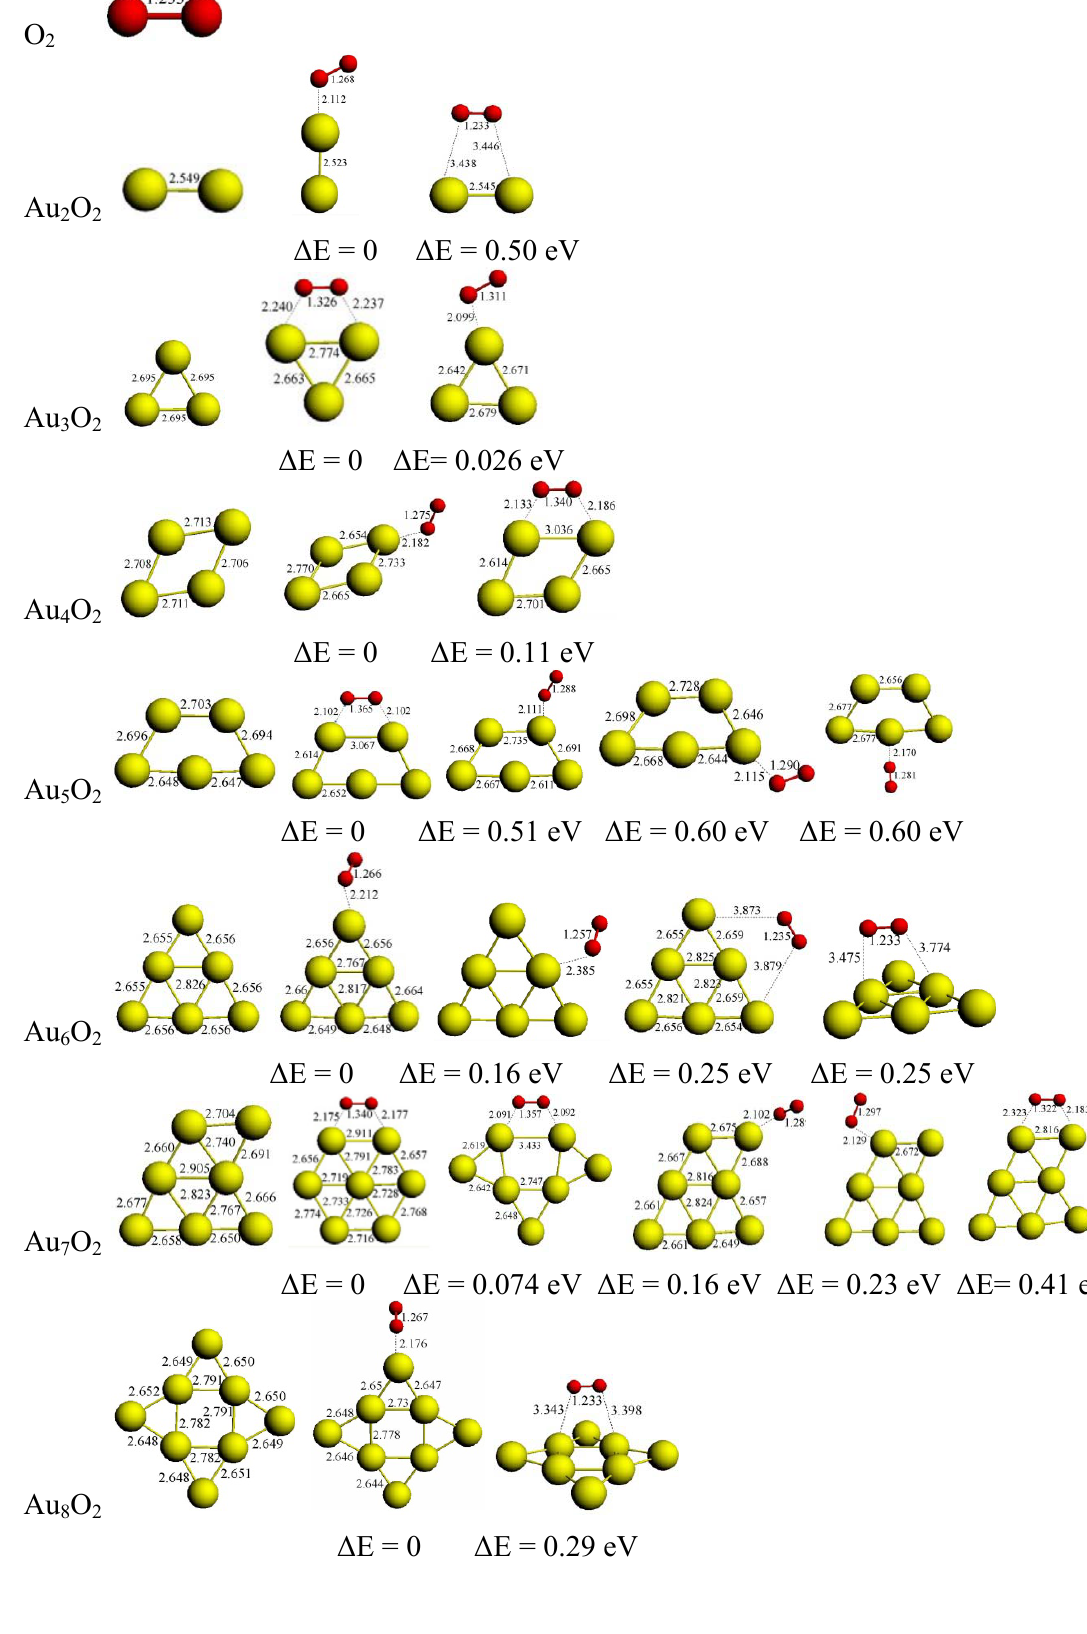
Figure 1. Optimized geometries for pure Au O ( n = 2–10) complexes (distances are in Au n 2